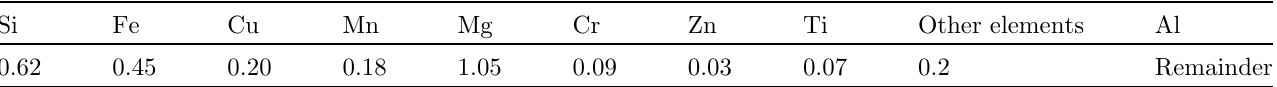
Table 1. Composition of Al 6061 alloy. Si Fe Cu Mn Mg Cr Zn